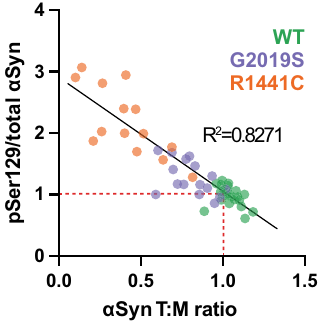
Fig. 6 Signi fi cant ( p < 0.0001) negative correlation between α Syn T:M ratio and pSer129 phosphorylation. Each dot represents a neuronal sample for which both the pSer129 level and the T:M ratio of α Syn was quanti fi ed (without any inhibitor treatment). WT controls (corrected lines also without inhibitor treatment) were normalized to 1 for both ratios (red dotted lines).